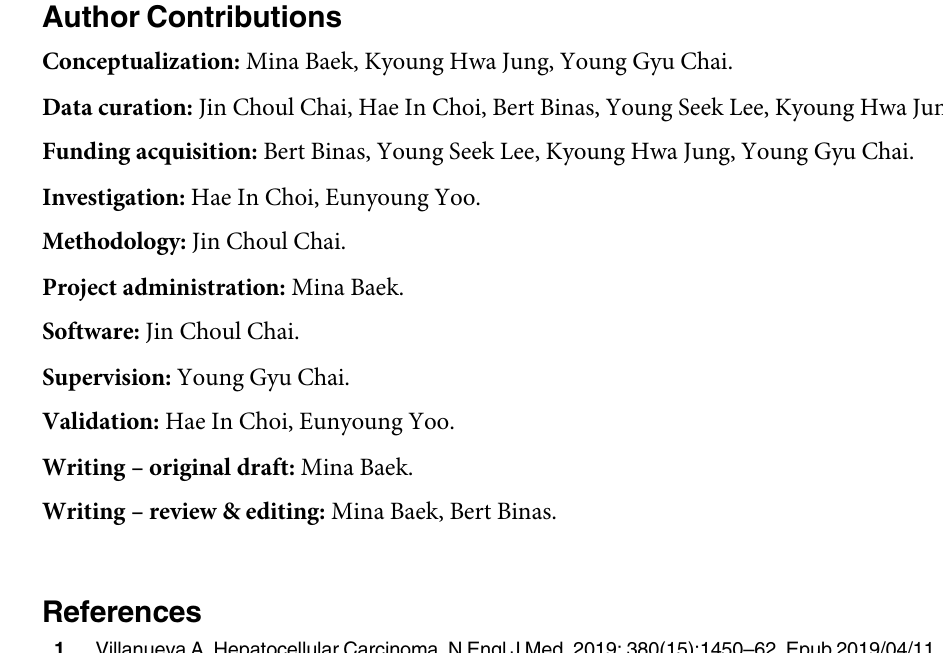
S8 Table. Top 50 significant up- and downregulated DEmRNAs in BET inhibitor-treated HepG2 cells in common. S9 Table. Top 50 significant up- and downregulated DElncRNAs in BET inhibitor-treated HepG2 cells in common. S10 Table. Pearson correlation coefficients (PCC) value of DElncRNA-DEmRNA pairs in Module 1. S11 Table. Pearson correlation coefficients (PCC) value of DElncRNA-DEmRNA pairs in Module